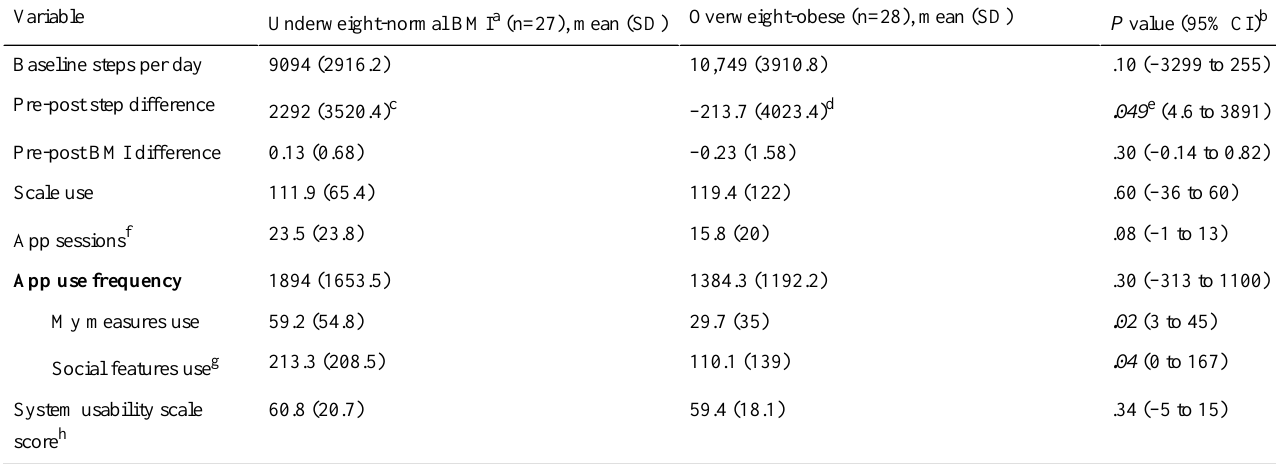
Table 2. Differences in characteristics of underweight-normal BMI and overweight-obese participants.